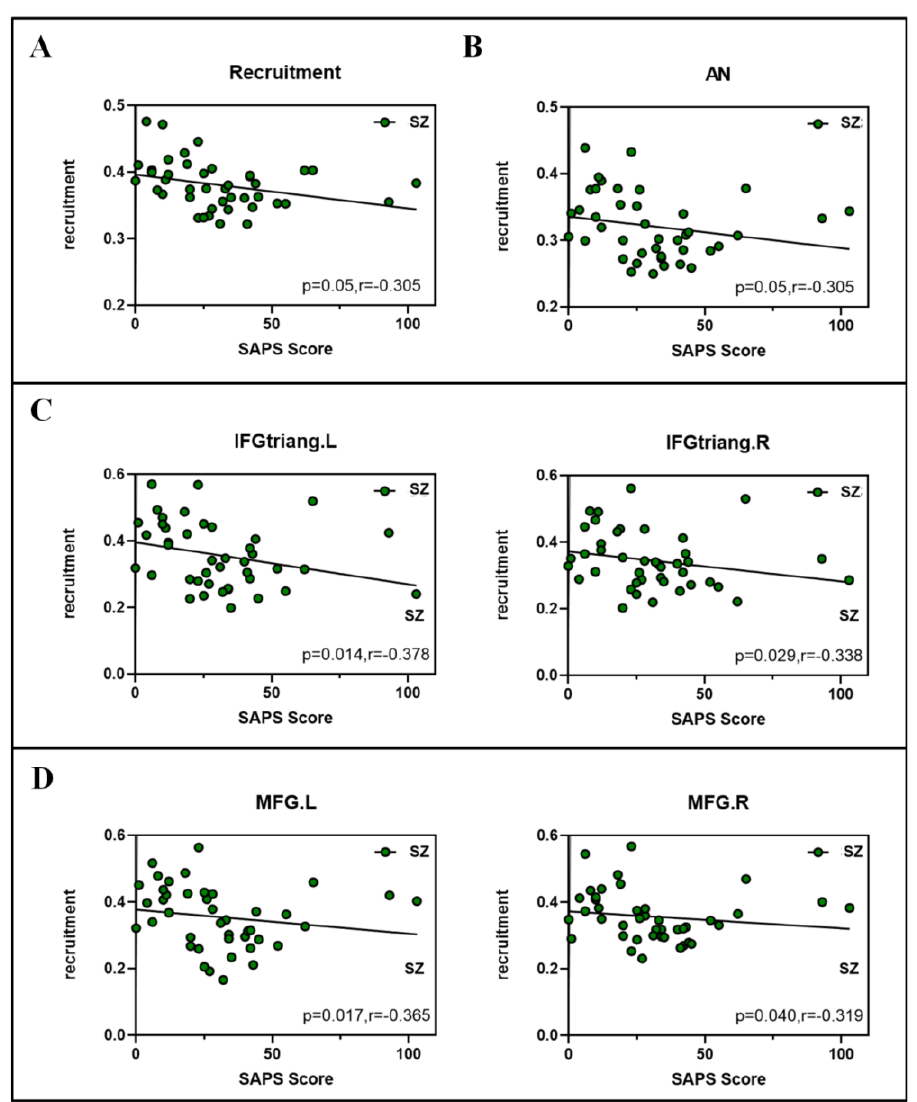
Figure 7. Spearman correlations between dynamic properties and ASRS scores in slow3 (0.073–0.198 Hz). ( A ) Recruitment ( B ) Recruitment in the attention network (AN). ( C ) Recruitment in the inferior frontal gyrus, triangular part (IFGtriang) and ( D ) middle front gyrus (MFG).